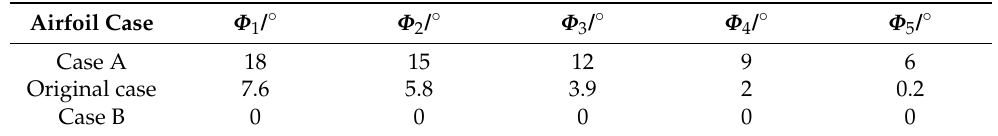
Table 1. Distribution of airfoil camber angle on different radius sections.